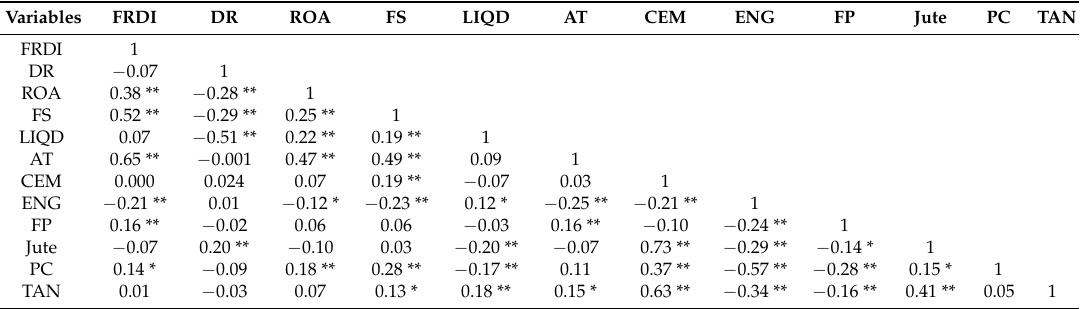
Table 3. Correlation matrix. DR—disclosure risk; CEM—cement industry; TAN—tannery industry; PC—Pharmaceuticals and Chemical industry; ENG—Engineering industry; FP—fuel and power industry and other variables as defined previously.